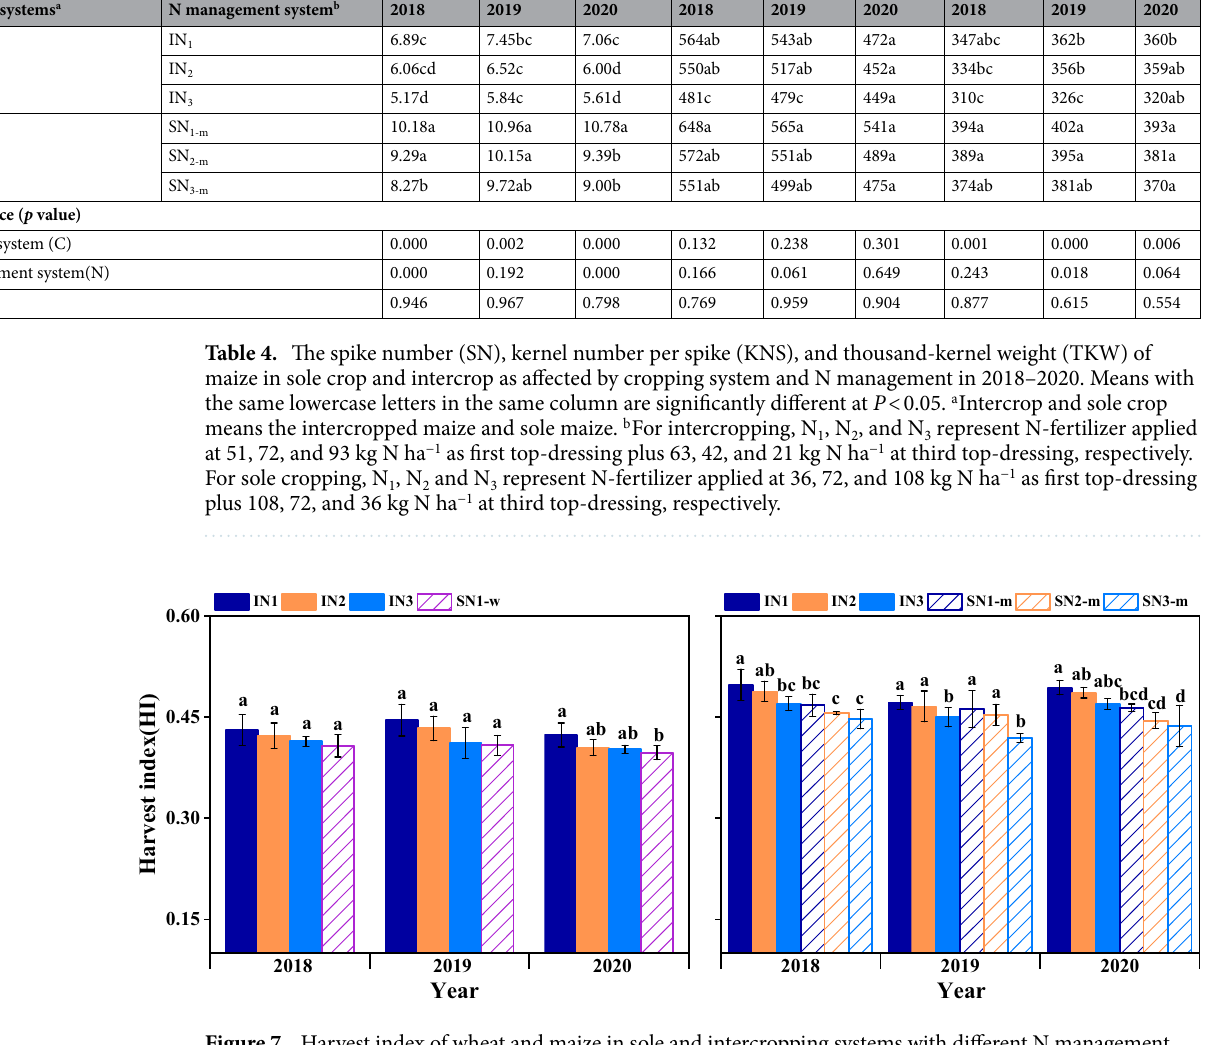
Figure 7. Harvest index of wheat and maize in sole and intercropping systems with different N management practices in 2018–2020. I, intercropping, S, sole cropping. For intercropping system, N 1 , N 2 , and N 3 represent N-fertilizer applied at 51, 72, and 93 kg N ha −1 as first top-dressing plus 63, 42, and 21 kg N ha −1 at third top- dressing, respectively. For sole maize, N 1 , N 2 and N 3 represent N-fertilizer applied at 36, 72, and 108 kg N ha −1 as first top-dressing plus 108, 72, and 36 kg N ha −1 at third top-dressing, respectively. For sole wheat, N 1 represents the N-fertilizer applied at 108 kg N ha −1 as base fertilizer at sowing plus 72 kg N ha −1 top-dressed at pre-tasseling. Different lowercase above bars indicates significant difference ( P ≤ 0.05) among different N managements. Error bars indicates standard error of the means ( n =